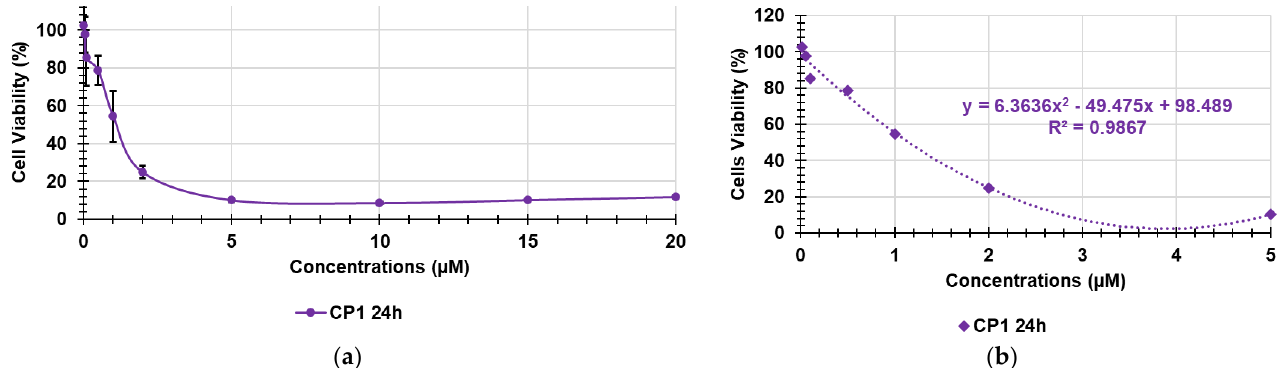
Figure 4. Curve of MAIL-2 cell viability (%) vs. concentrations (0.01 – 20 µM) of CP1 at 24 h ( a ); polynomial tendency line fitting the dispersion graph shown in Figure 4a (0.01–5 µ M) ( b ).